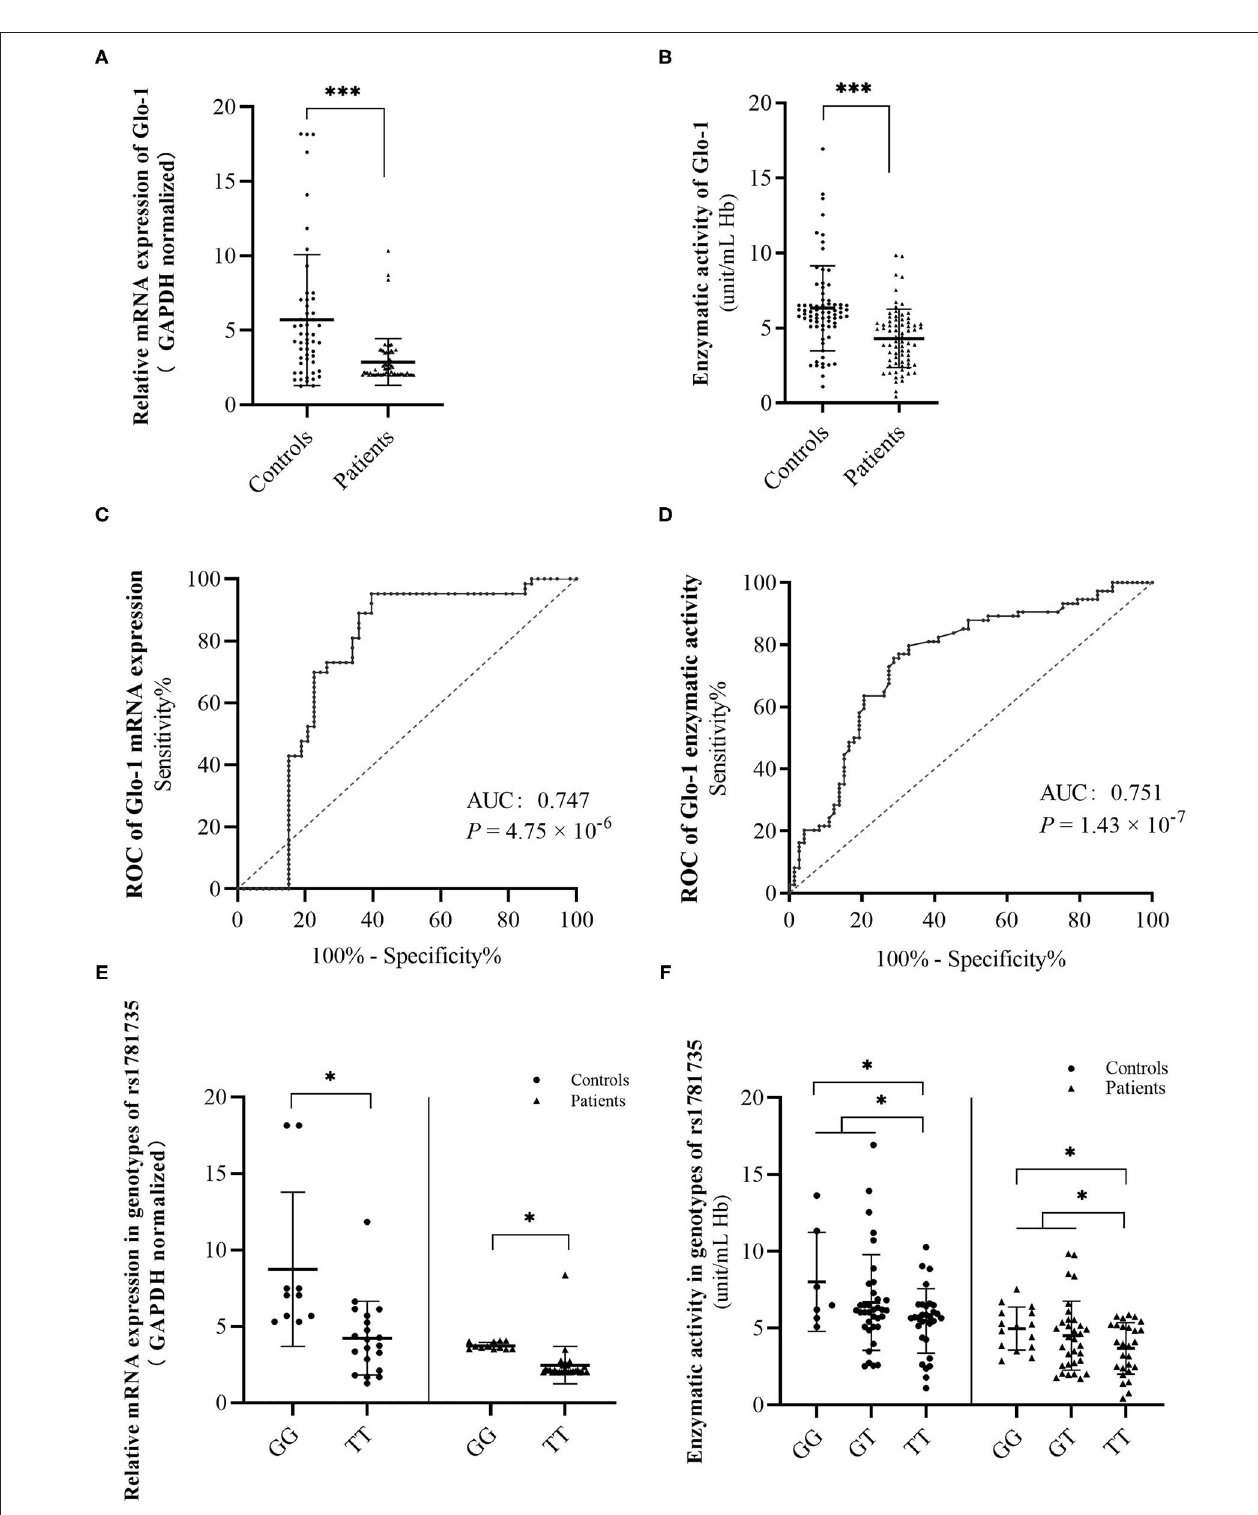
FIGURE 2 | Discrimination of glyoxalase 1 (Glo-1) mRNA levels (A) and enzymatic activity levels (B) in peripheral blood from the first-onset antipsychotic-naïve patients with schizophrenia and healthy controls. A receiver operating characteristic (ROC) curve was constructed to evaluate the role of Glo-1 mRNA expression (C) and enzymatic activity (D) in the diagnosis of schizophrenia. Discrimination of Glo-1 mRNA levels (E) and enzymatic activity levels (F) in genotypes of rs1781735 in peripheral blood of first-onset antipsychotic-naïve patients with schizophrenia and healthy controls. AUC, the area under the ROC curve. *, P < 0.05. ***, P < 0.001. The error bar represents the SD of the